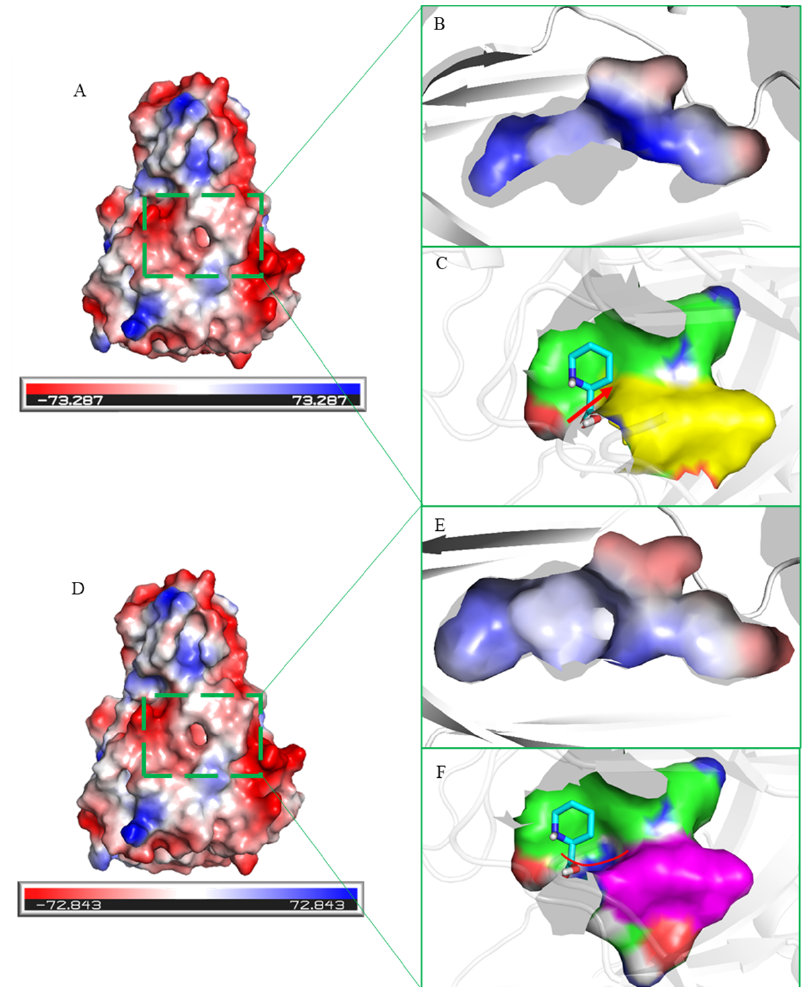
Figure 8. Comparison of the protein surface electrostatic potential energies between the WT and R97M. ( A , D ) Surface electrostatic potential energy of the WT and R97M. ( B , E ) Surface electrostatic potential energy near the substrate binding pocket of the WT and R97M. ( C , F ) Spatial conformation of the substrate binding pocket of the WT and R97M. The red arrows indicate the change of conformation of the substrate-binding